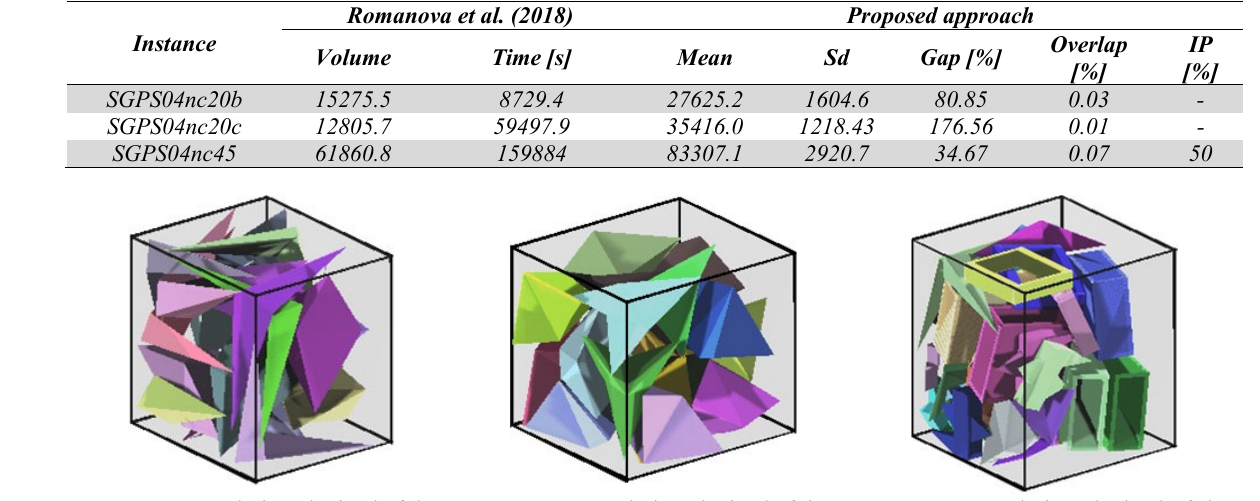
Fig. 26. Best solution obtained of the Fig. 27. Best solution obtained of the Fig. 28. Best solution obtained of the